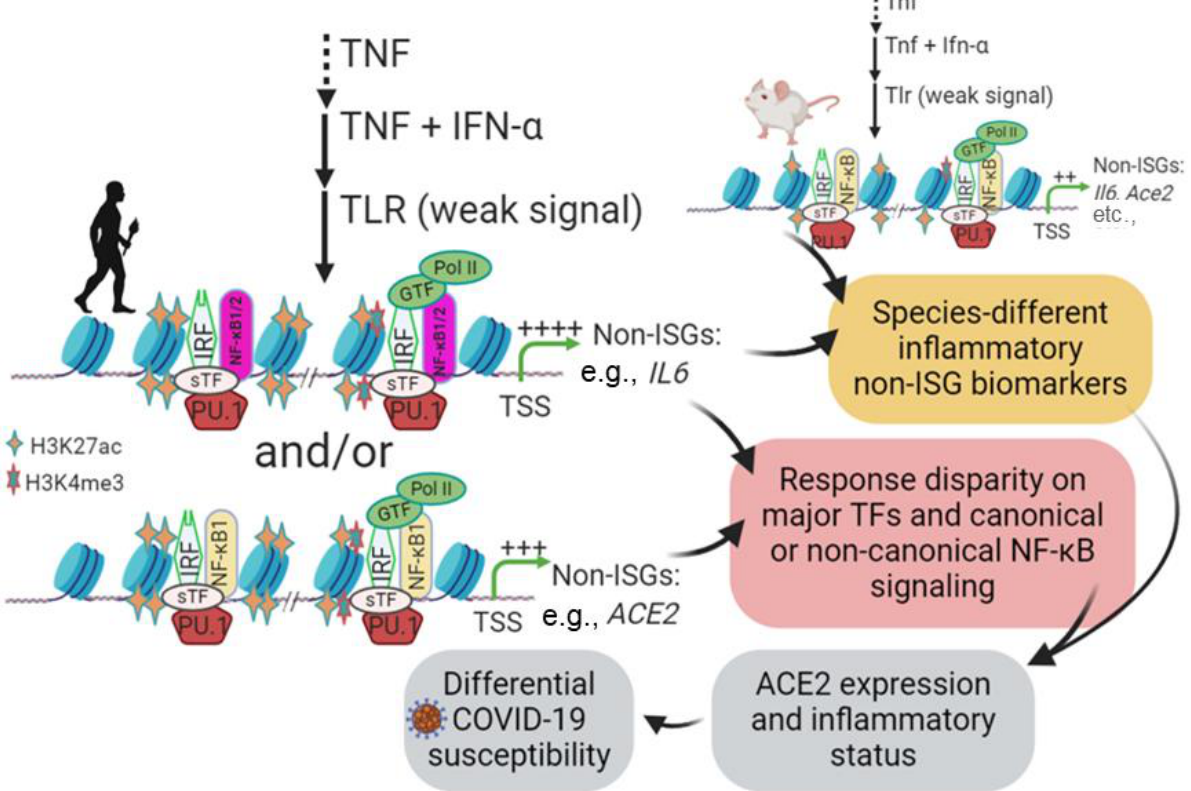
Figure 9. Working summary for IL-6 and ACE2 as non-ISGs biomarkers and contribution to COVID-19 susceptibility. Epigenetic regulation of non-ISGs such as IL-6 and ACE2 was sequentially regulated by TNF, IFN and TLR signaling, which modify chromatin accessibility through activating histone modification and recruitment of transcription factors including PU.1, IRF and NF- κ B binding on promoter regions of IL-6 and ACE2 genes. In turn, it will amplify inflammatory loops through IL-6-mediated responses and induce more ACE2 expression, which collectively contributes to the occurrence of respiratory distress syndrome, as in COVID-19. Therefore, high expression of non-ISGs such as IL-6 and ACE2 could be biomarkers to determine COVID-19 susceptibility and disease development in different animal species. Abbreviations: non-ISG, non-canonical interferon stimulated genes; GTF, sTF, or TF, general (G), tissue-specific (s) transcription factor (TF); TLR, toll-like receptor; TSS, transcription start site.